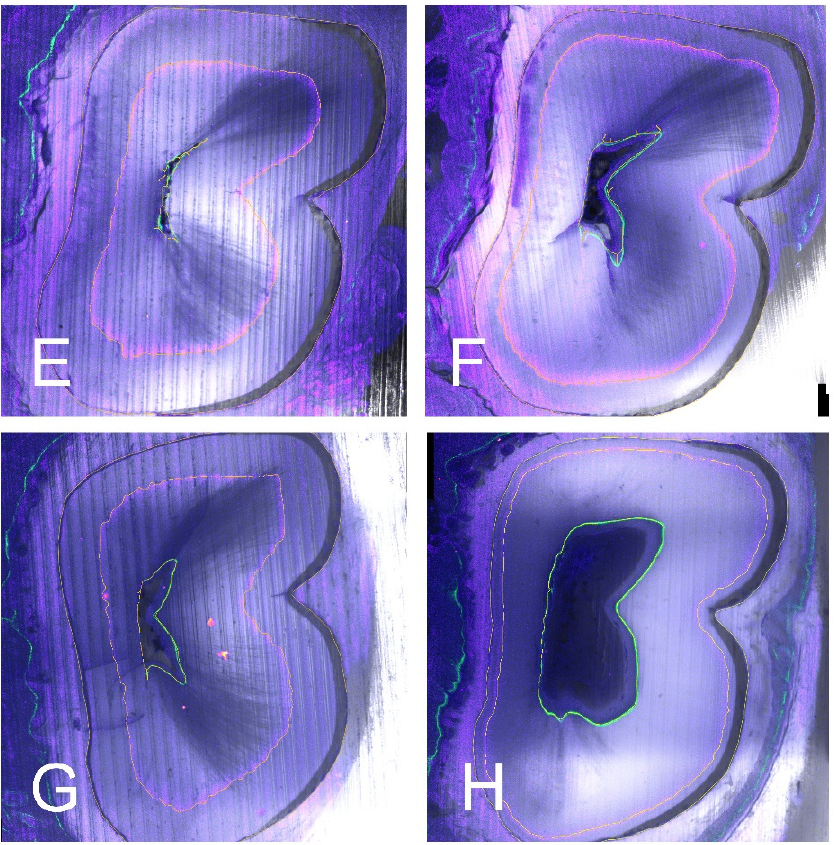
Figure 3. Representative examples of fluorescence images (Leica DM 6000B. Leica Microsystems, Heerbrugg, Switzerland. Leica CTR 6000, Leica Microsys-tems, Heerbrugg, Switzerland), of A sec- tions ( A , C , E , G ) and B sections ( B , D , F , H ). Special filters were used (Ca: calcein green, Te: tetracycline purple). Four different teeth with the different treatments: ( A , B ) Negative control. ( C , D ) MTA group. ( E , F ) poor PRGF. ( G , H ) rich PRGF. Note the higher area of dentin growth in rich PRGF group ( G , H ) for both A and B sections, followed by poor PRGF group ( E ,F) and MTA group ( C , D ). Finally, the lowest dentin growth area for NC group ( A , B